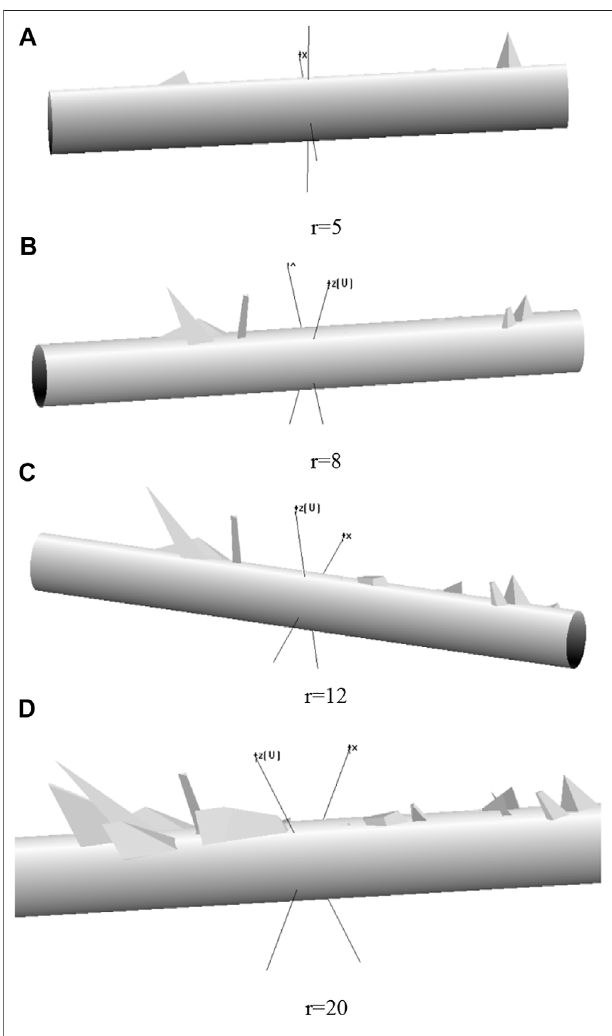
FIGURE19| Thedisplayofthekeyblocksformedbydiscontinuitieswith different radii. (A) r = 5, (B) r = 8, (C) r = 12, (D) r =